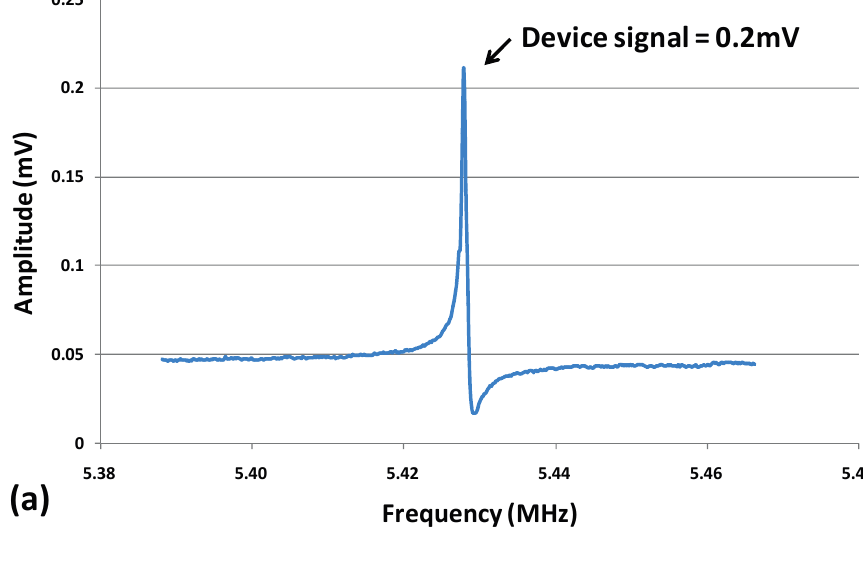
Figure 16. Frequency response ( a ) and spectral density ( b ) of the output signal of the 5.43 MHz dog-bone probe measured by a Nanonis controller. The resulting SNR is 1000 √ Hz ( V DC = 3 V, V AC = 1.23